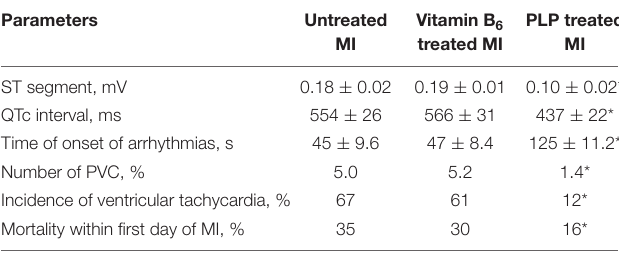
TABLE 2 | Effects of vitamin B 6 and its metabolite, pyridoxal 5 (cid:48) -phosphate (PLP) on myocardial infarction (MI) induced arrhythmias and mortality in rats.